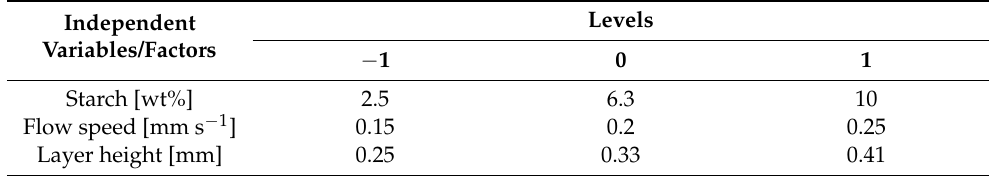
Table 4. Levels and respective values used for each independent variable of the design of experiments.